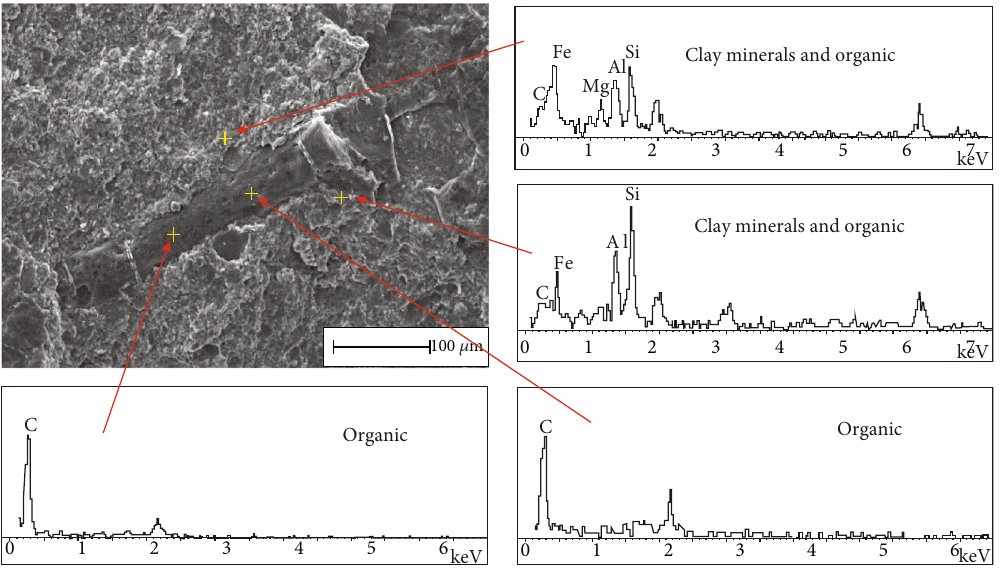
Figure 4: Graptolite photographs and energy spectrum of the Wufeng-Longmaxi Formation shale in the southeast Sichuan Basin. The fragment is graphitic, that is, mainly composed of carbon. The fragment is encased in clay minerals and carbonate minerals.